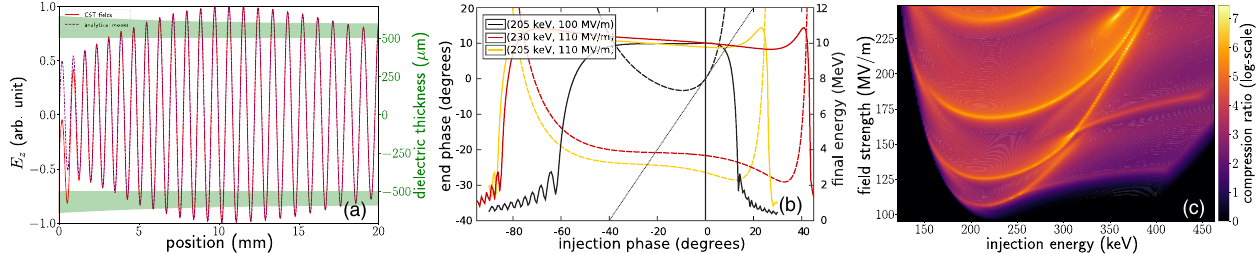
FIG. 2. (a) Geometry of the dielectric-layer tapering (green shaded area, right axis) over the entrance of the structure; the initial dielectric thickness is 143 μ m ( v p ¼ 0 . 7 c ) and asymptotically approaches 91 μ m ( v p ¼ c ). In addition we show the comparison between our analytic field ansatz with FDTD code CST - MWS over the first 20 mm. (b) Final energy (solid traces, left column) and end phase (dashed lines, right column) as a function of injection phase for various accelerating gradients and initial kinetic energies. The black diagonal dashed line shows ϕ e ¼ ϕ i , intersections with the phase portraits indicate zero phase-slippage. (c) The compression ratio between the injection phase and end phase, Δ ϕ i = Δ ϕ e in log-scale as a function of injection energy and accelerating gradient for an input bunch length spanning 60 deg ( Δ ϕ i ¼ 60 deg.)